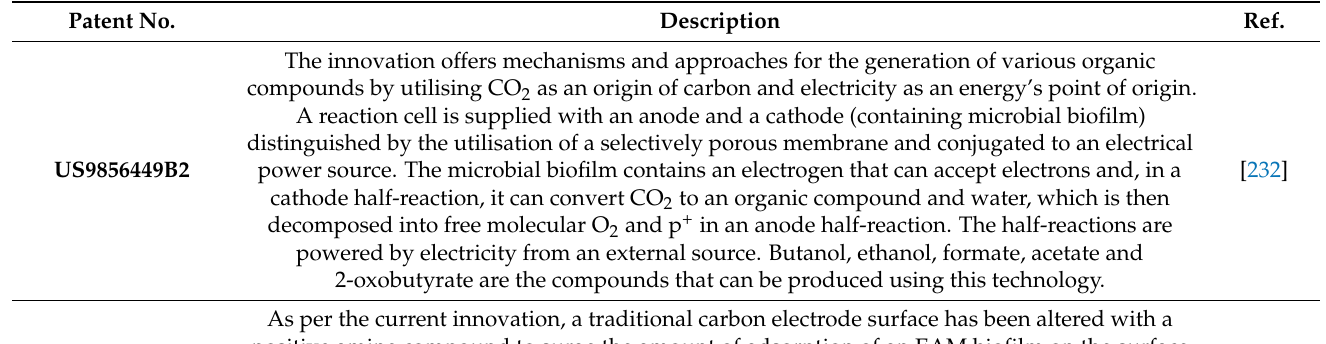
Table 7. Several existing patents concerning microbial electrosynthesis (MES). Patent No. Description